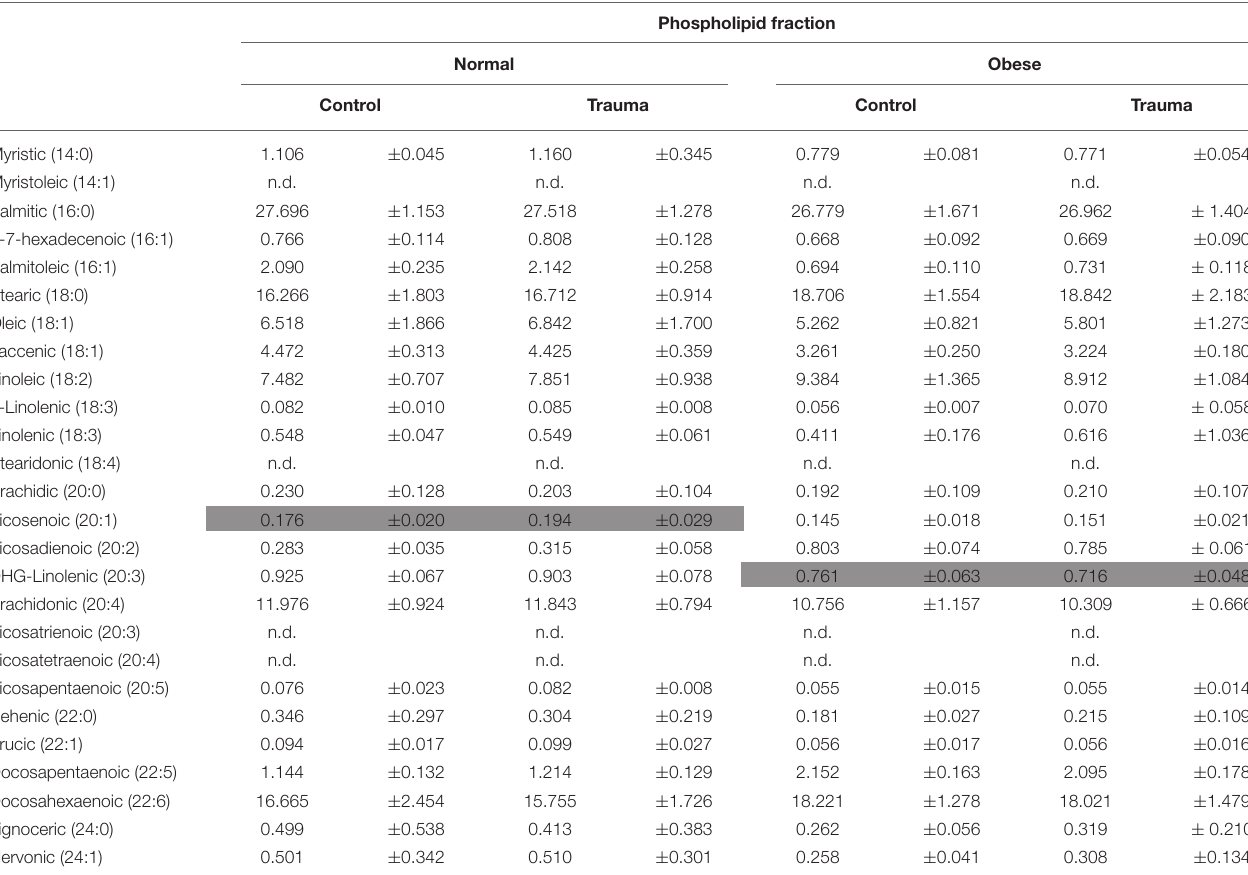
tissue at all-time points, separated by thin-layer chromatography and analyzed by gas chromatography ( Table 5 ). Stearidonic, eicosatrienoic and eicosatetraenoic acid could not be detected, whereas palmitic, oleic and linoleic acid reached at least 10%